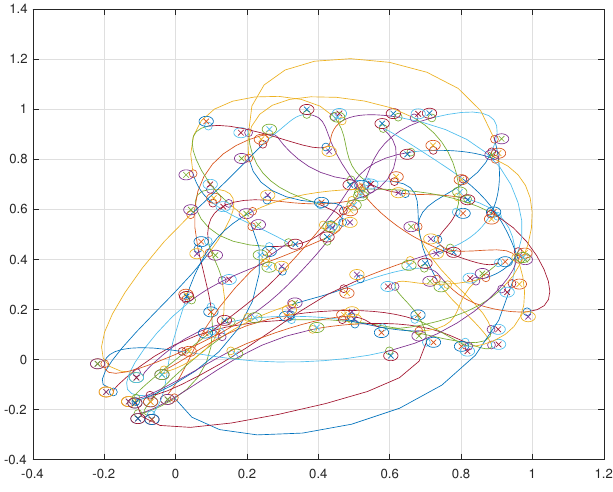
Figure 42. Ten agents visiting ten neighborhoods